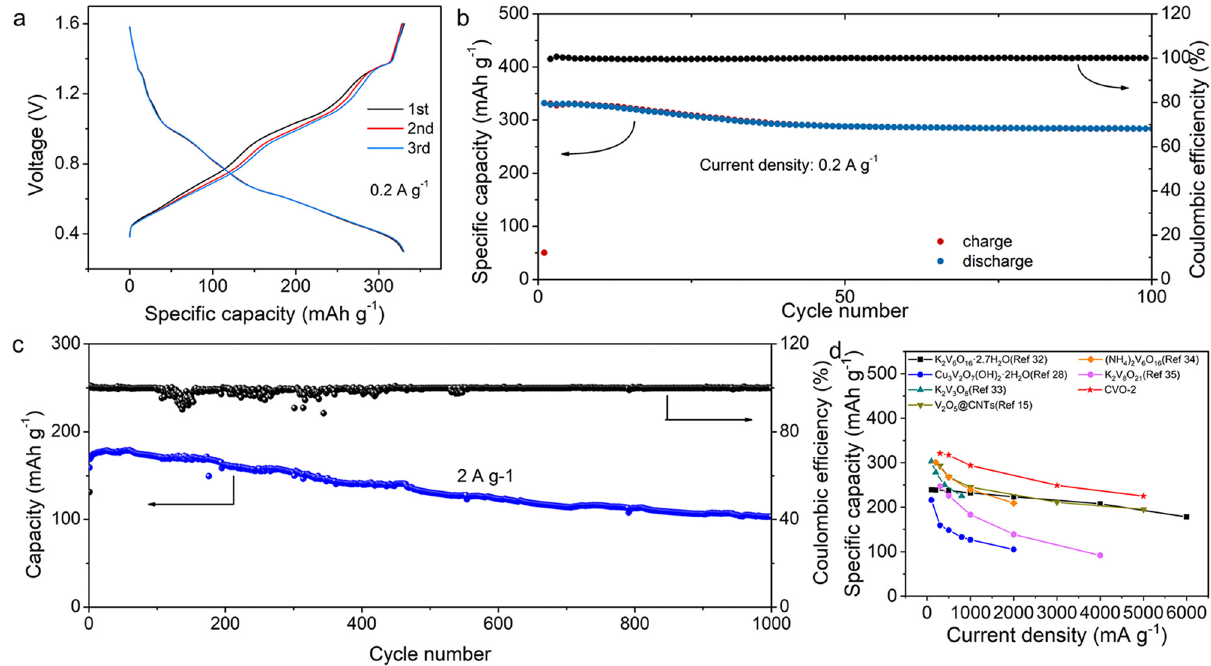
Figure 4: ( a ) Galvanostatic charge/discharge ( GCD ) curves of CVO - 2 in the initial three cycles at 0.2 A g − 1 . ( b ) The discharge/charge pro fi les of CVO - 2 at 0.2 A g − 1 . ( c ) The cycling performance of CVO - 2 at 2 A g − 1 . ( d ) Comparison of the CVO - 2 electrode with previously reported vanadium oxide cathode materials for